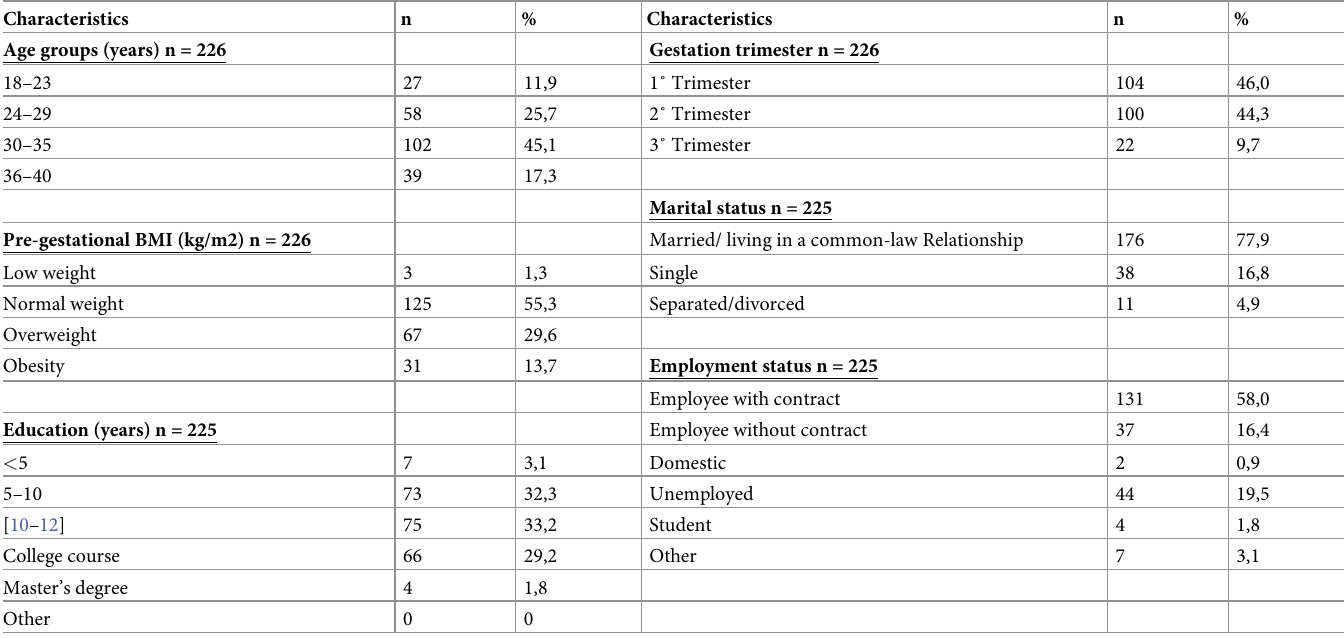
Table 5. Sociodemographic data (n = 226) of sample 2 related to the PPAQ validity test. Characteristics